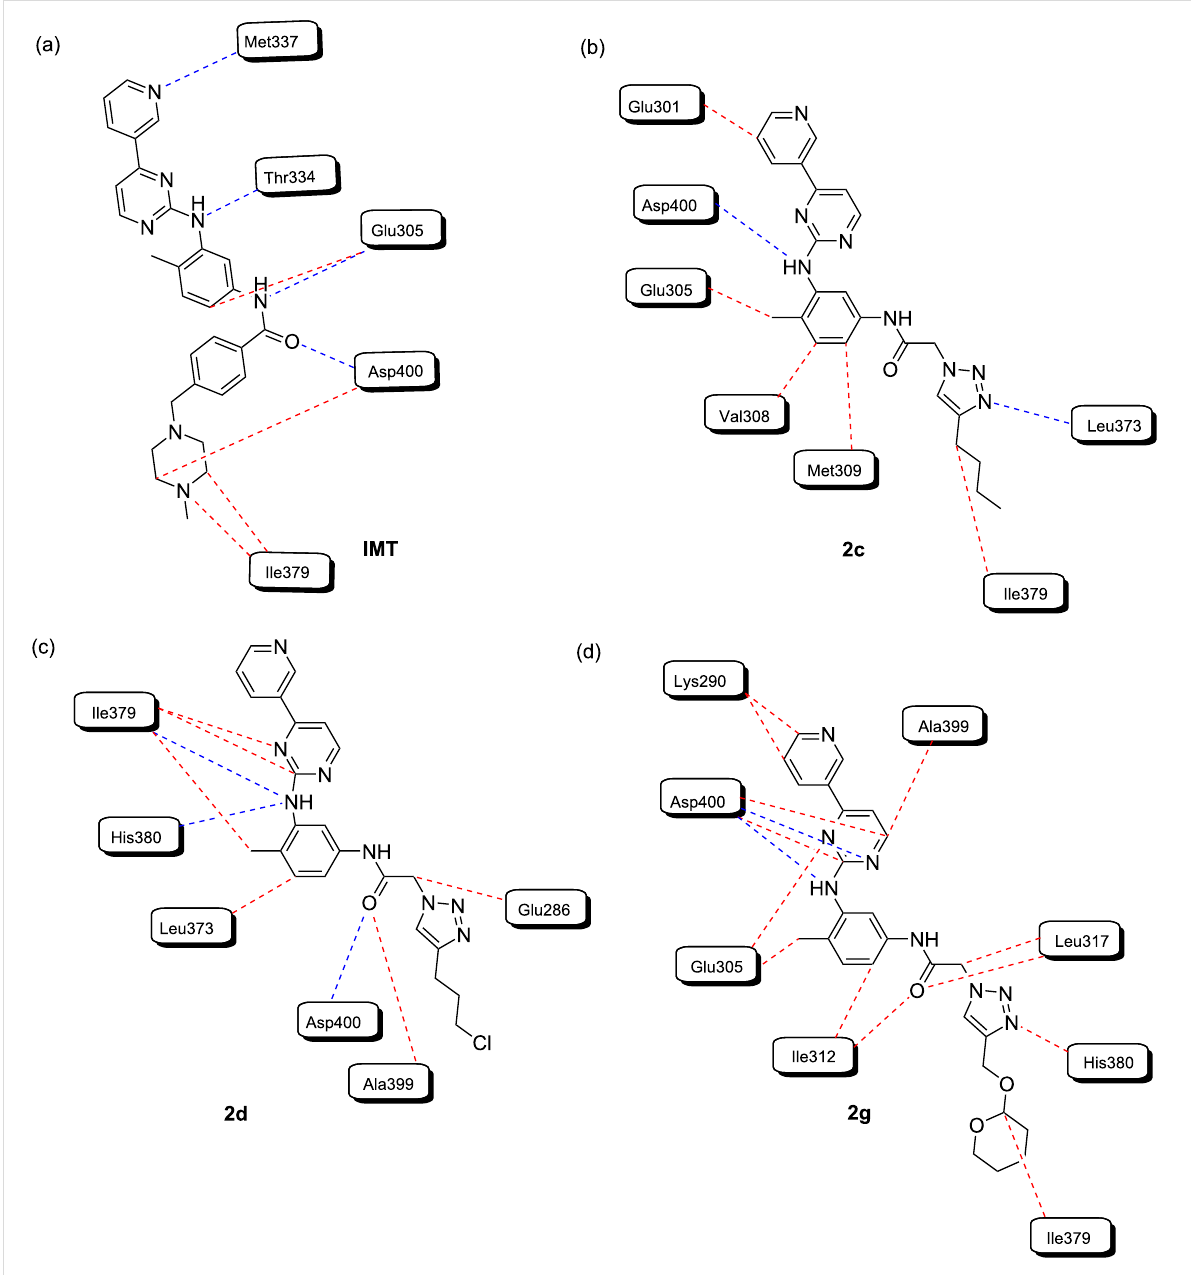
Figure 4: Interaction maps of IMT, 2c , 2d , and 2g with the BCR-Abl-1 structure (PDB code: 3PYY), showing steric interactions (red dotted lines) and hydrogen bonds (blue dotted lines).